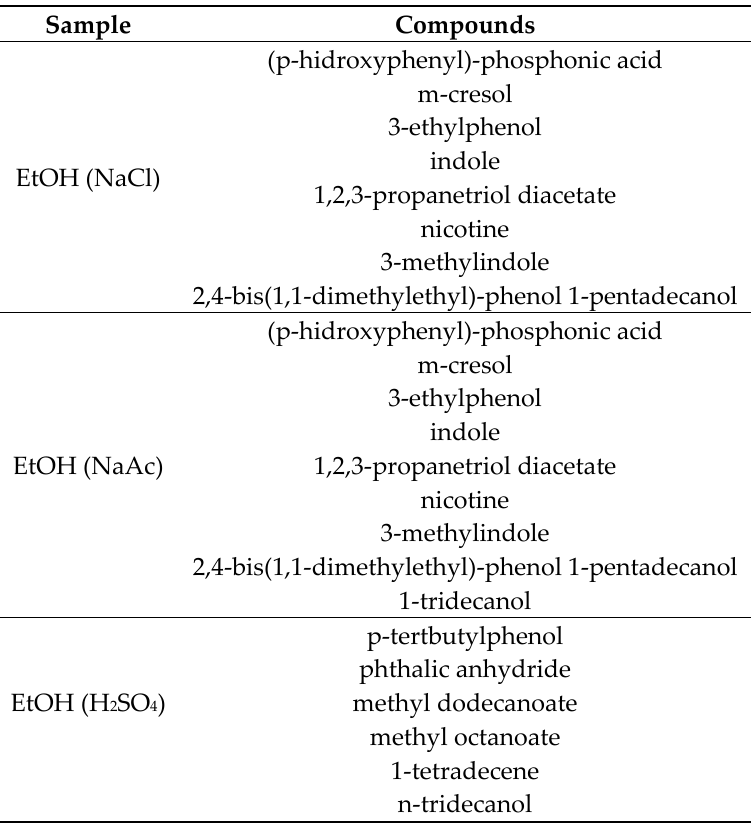
Table 1. Organic compounds extracted from cigarette butts by absolute